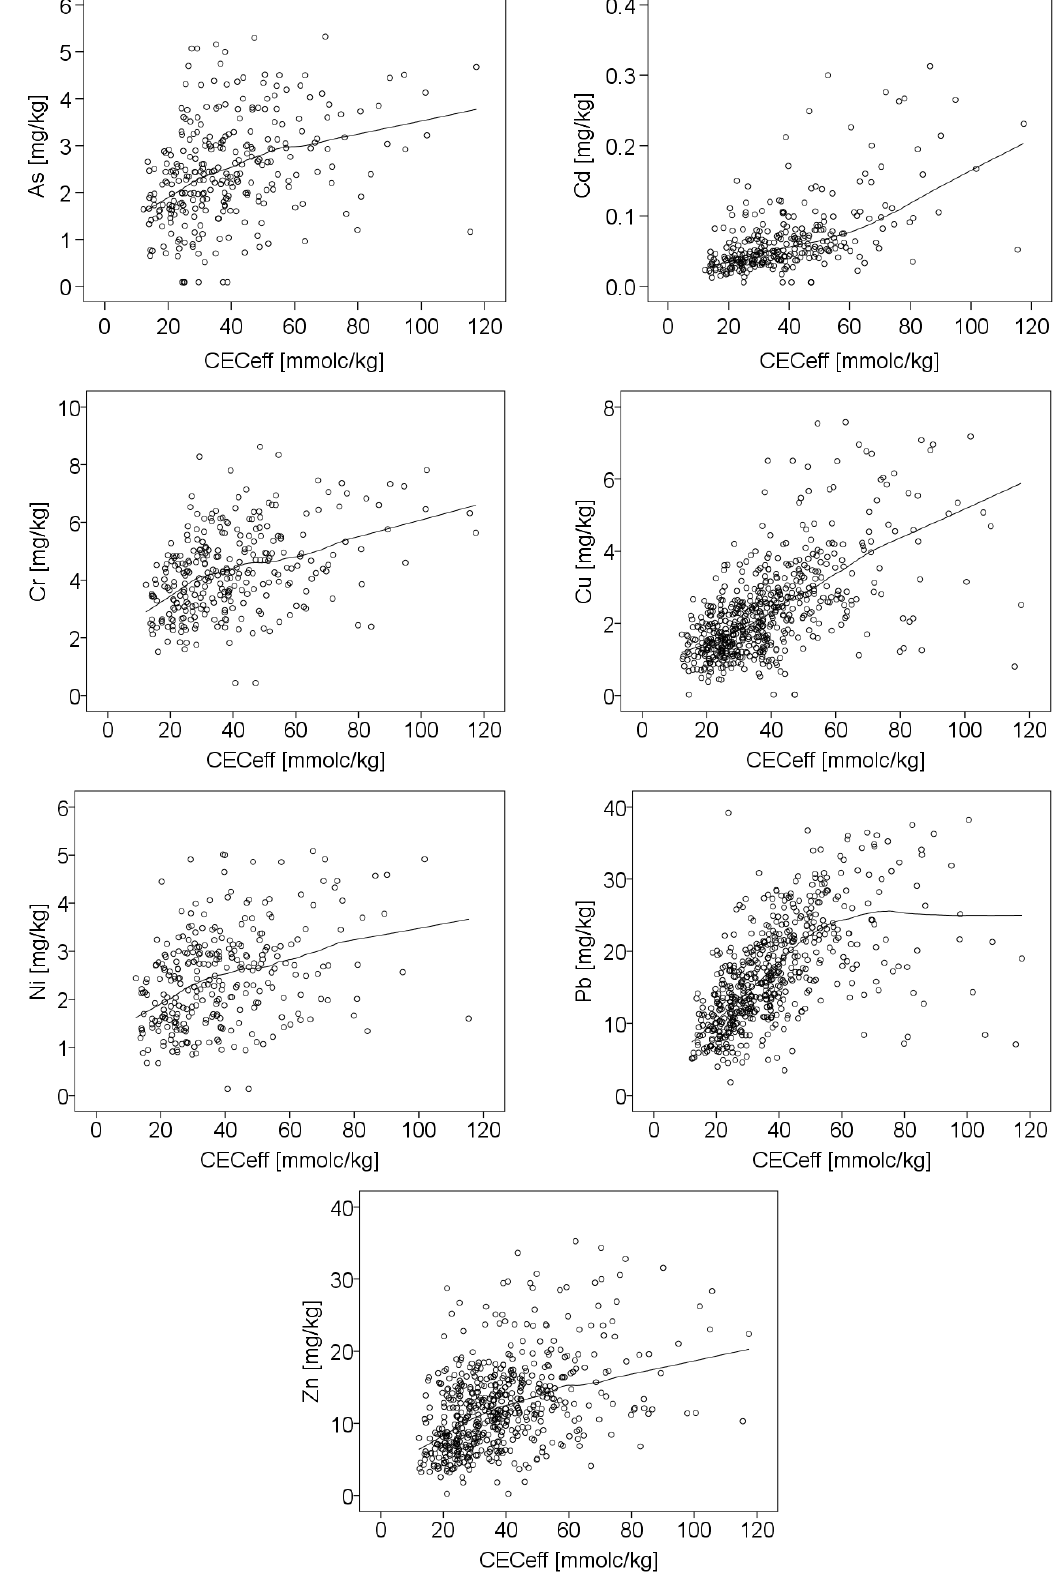
Figure 2. Scatterplots of the As, Cd, Cr, Cu, Ni, Pb and Zn concentrations and the effective cation exchange capacity (CEC eff ) at 0–5 cm and 5–10 cm soil depth, and smoothed adaption function (LOESS